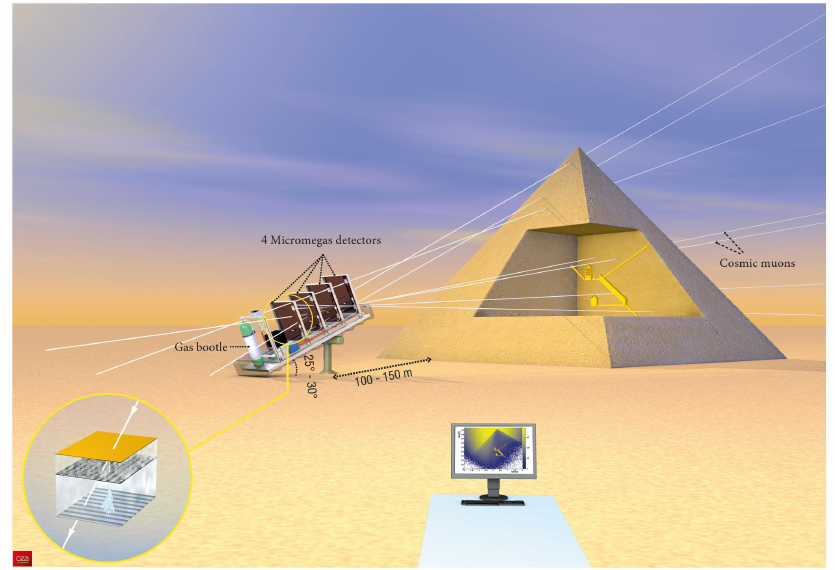
Figure 13. Schematic view of the principle of muography with a Micromegas-based telescope of a pyramid (Illustration by Fabrice Mathé, Les défis du CEA N o 210, Septembre 2016). Muon flux density images traced from the telescope position are acquired for different directions. A 3-dimensional image can be produced by combining several images of the same object from different